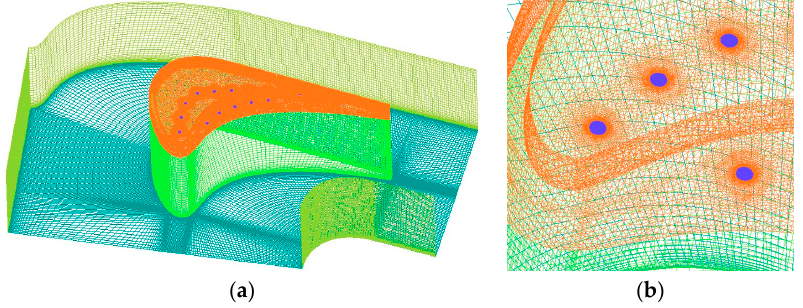
Figure 4. Computational meshes: ( a ) Meshes of the blade passage; ( b ) Meshes at the tip.